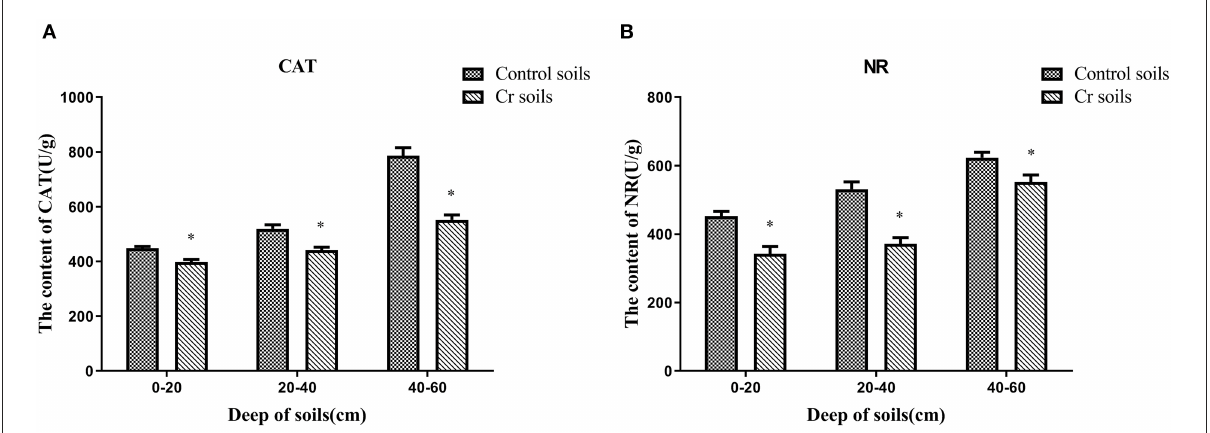
FIGURE13 Antioxidant enzyme (NR and CAT) contents of soils (A, B) . Data showing the diverse depths between Control and Chromium soil groups are presented as the mean ± SD. Values in the same row with “*” were significantly different ( p < 0.05) in the same depth between the Control and Chromium groups. All data in the experiment represent three independent